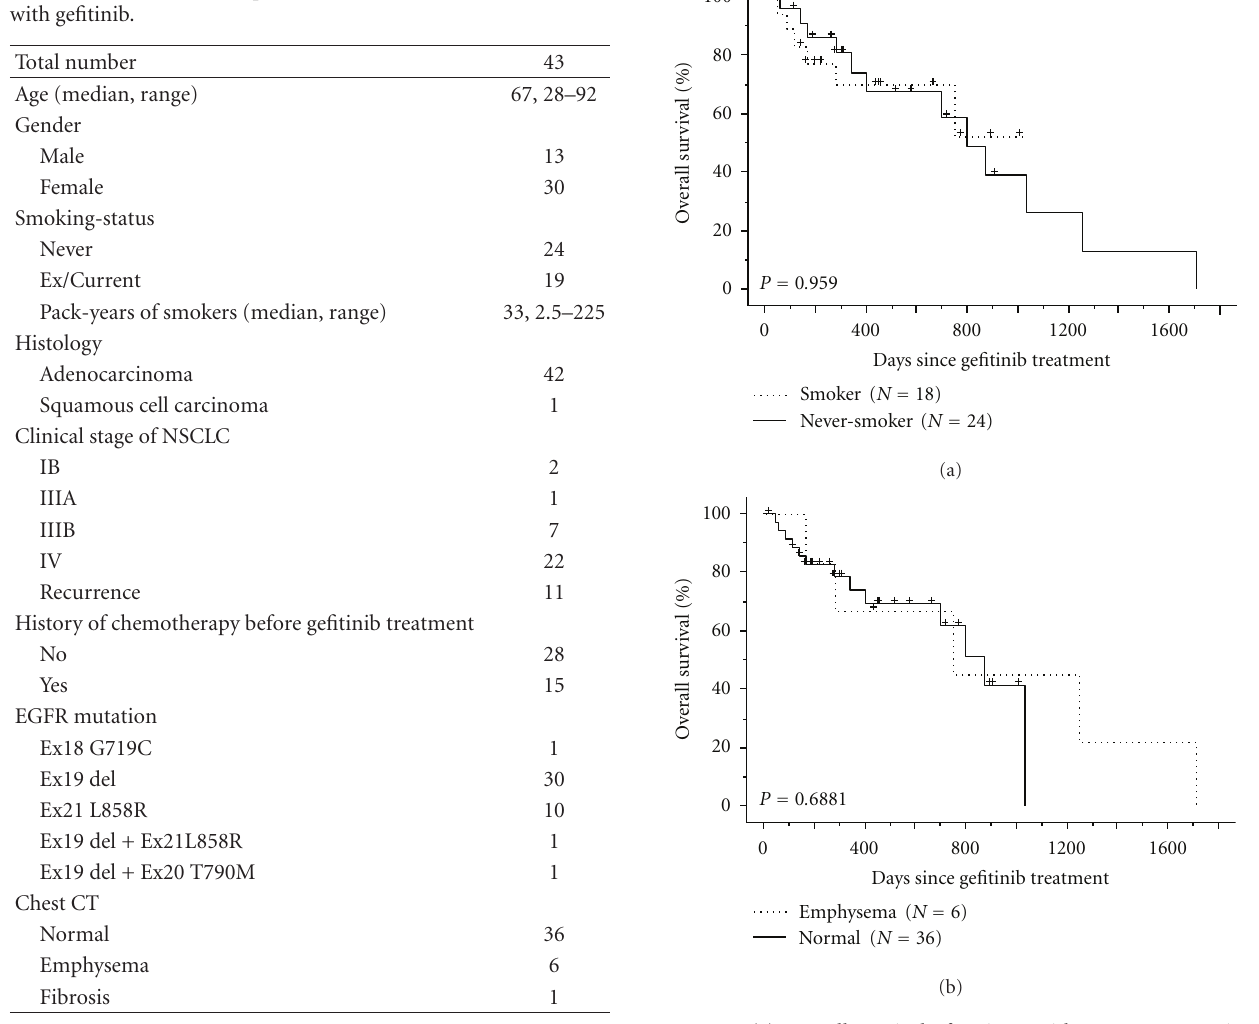
Figure 1: (a) Overall survival of patients with an EGFR mutation treated with gefitinib, according to smoking status (never smokers: solid line; smokers: dotted line). +: censored patient. (b) Overall survival of patients with an EGFR mutation treated with gefitinib, according to underlying pulmonary disease (normal: solid line; emphysema: dotted line). +: censored